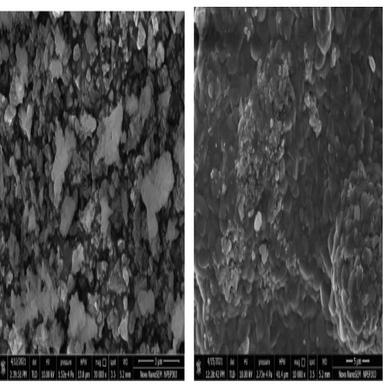
SEM analysis of nanoparticles Al2O3.